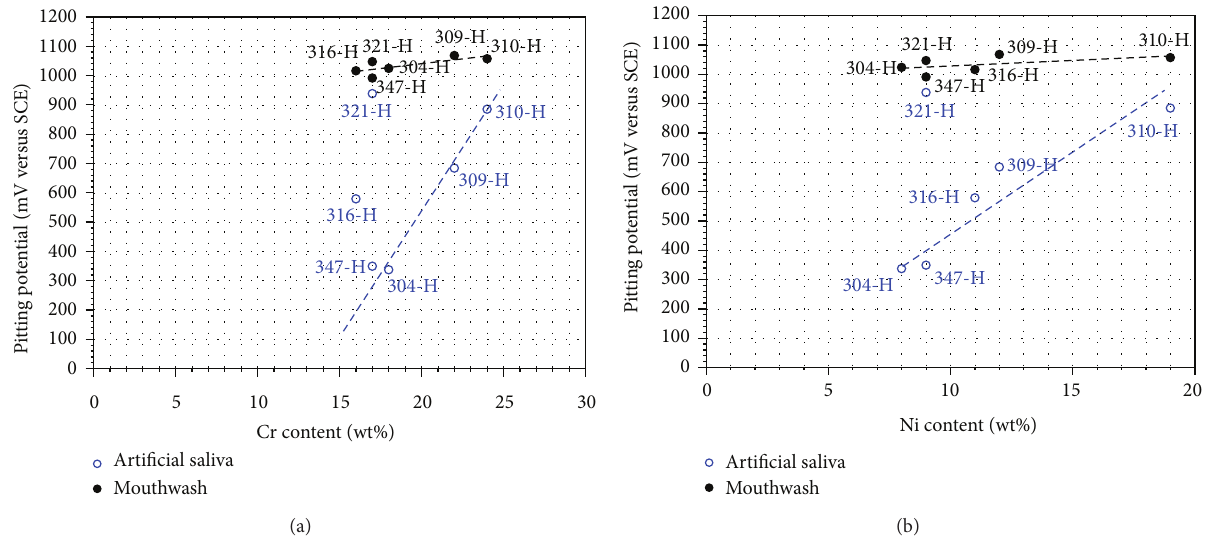
Figure 7: Effect of the Cr and Ni content of stainless steels on pitting